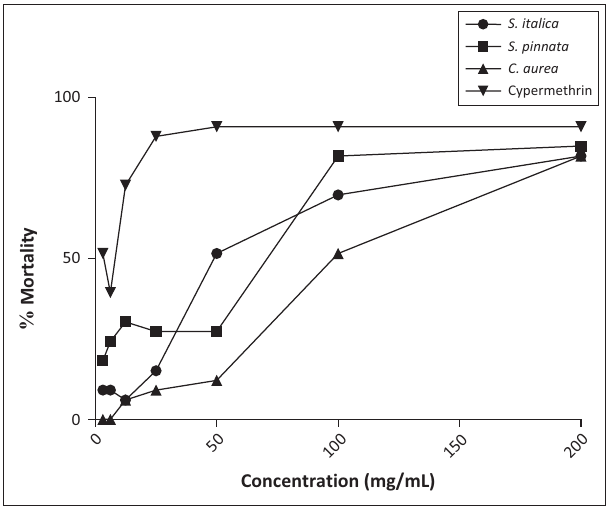
FIGURE 1: The dose-dependent mortality of the acetone extracts against Rhipicephalus turanicus